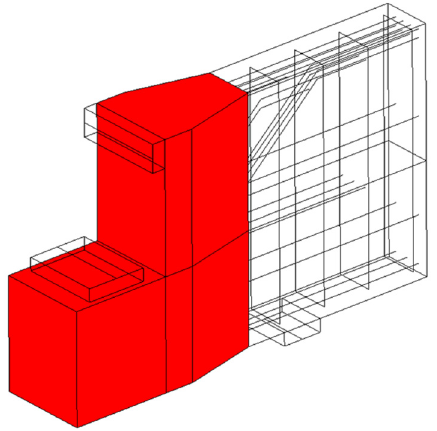
Figure 10. Surfaces exposed to chloride attack.